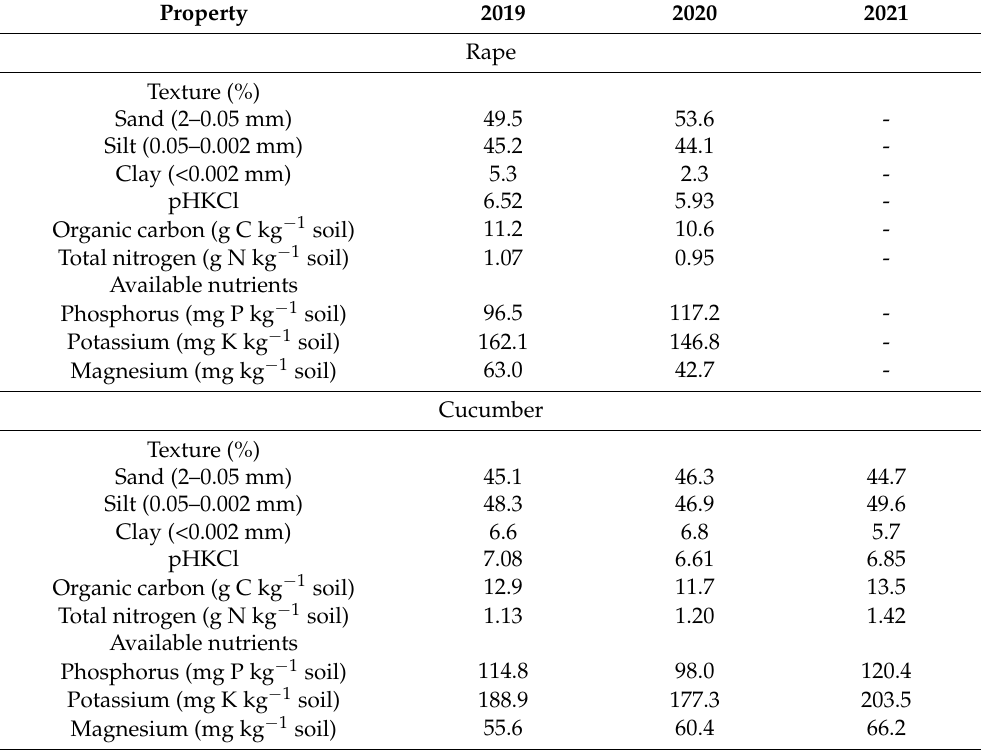
Table 1. Soil properties in site of field experiments.